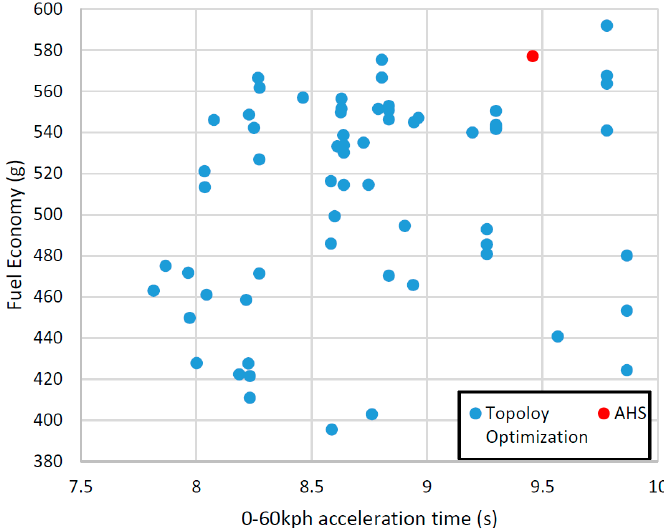
Figure 4. Fuel consumption and launching performance of survived designs and AHS hybrid.